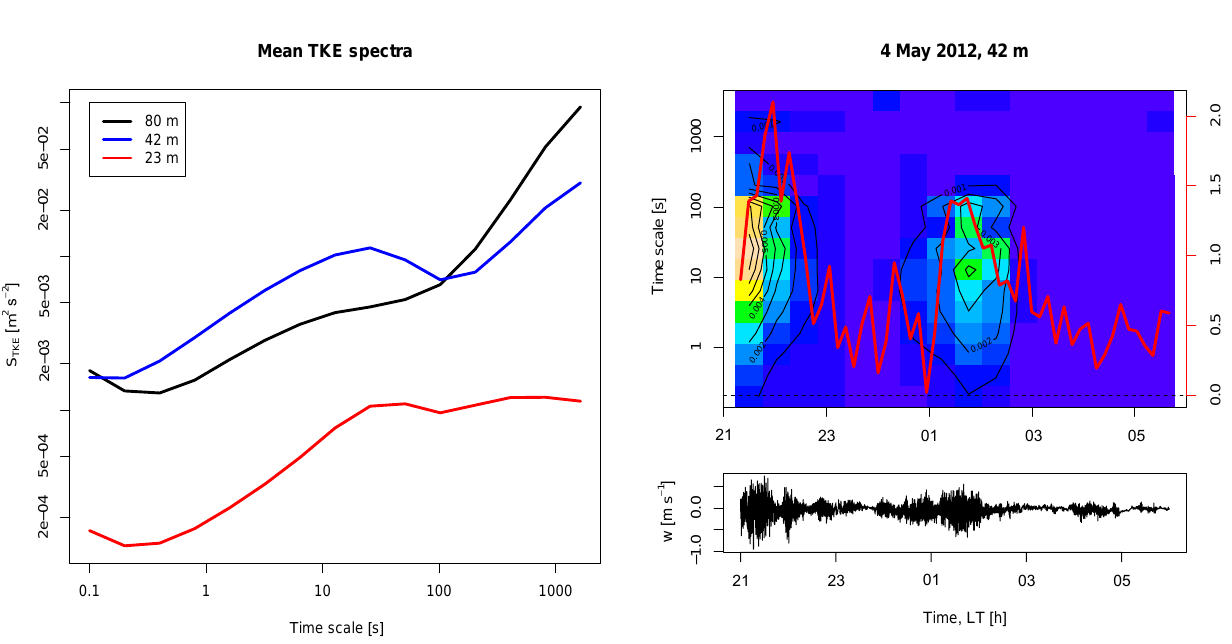
Figure 13. Mean multi-resolution turbulent kinetic energy (TKE) spectra at the three observation levels.